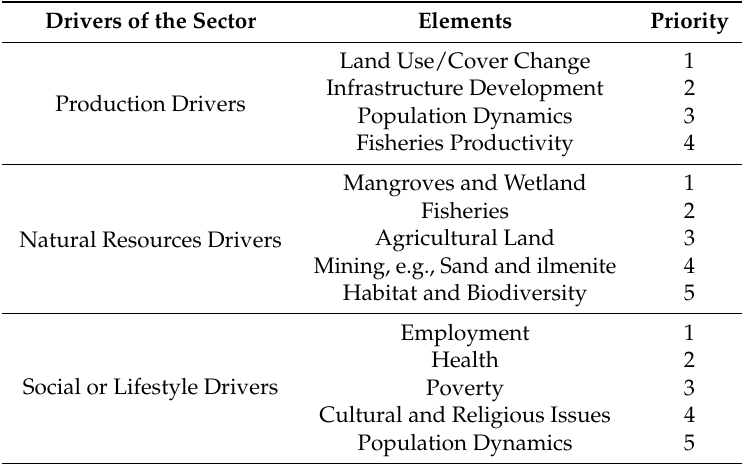
Table 3. Elements of the sector that are affected by Climate Change. Drivers of the Sector